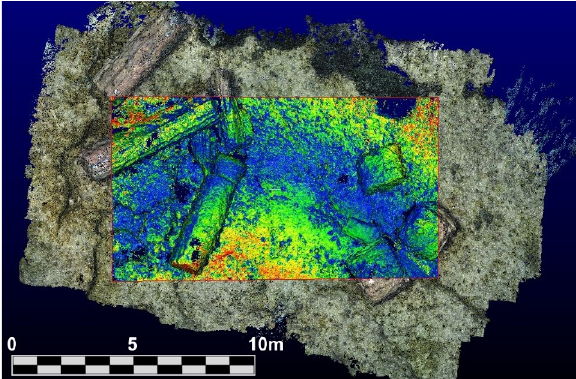
Figure 4. Rectangular portion of the model that has been compared